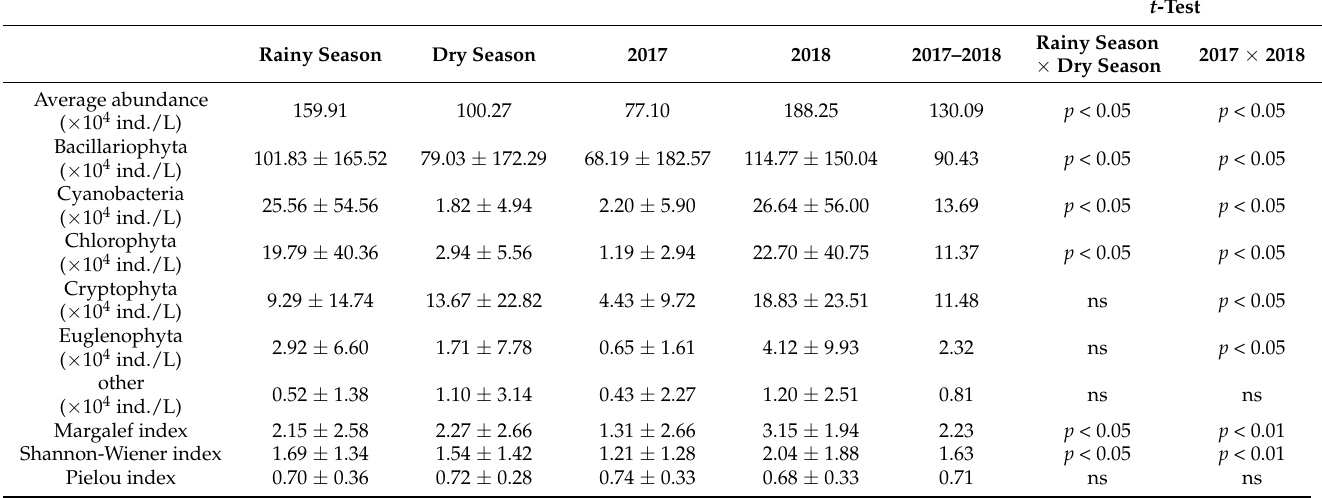
Table 2. The temporal and spatial variation of phytoplankton community structure and taxonomy diversity indices in Jingpo Lake from 2017 to 2018.